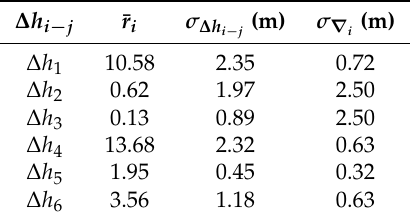
Table 7. Reliability numbers ( ¯ r i ) , standard deviation σ ∆ h σ ∇ for network ( b i